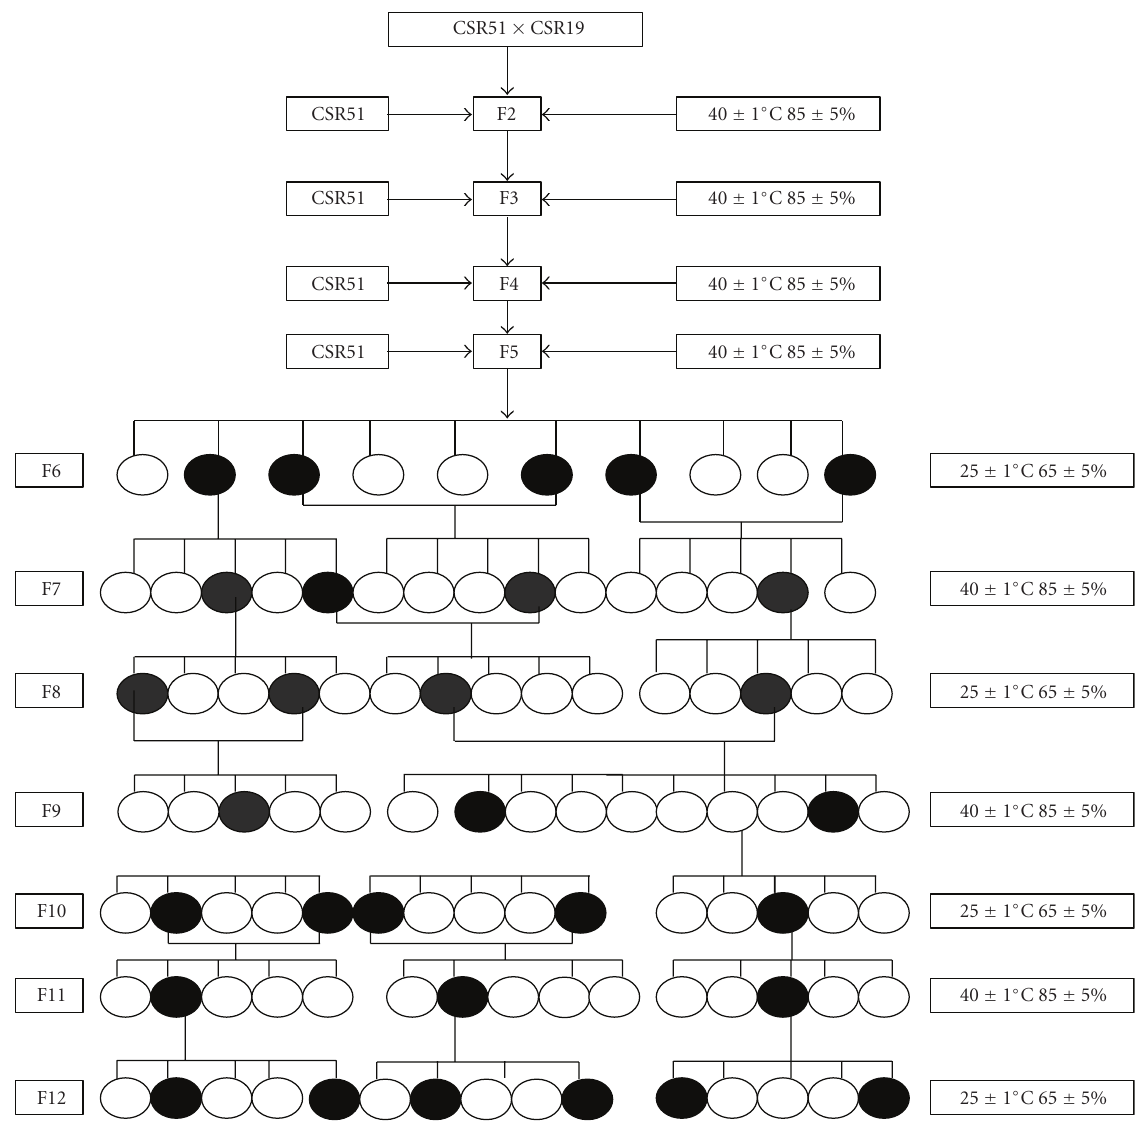
Figure 2: Breeding plan for